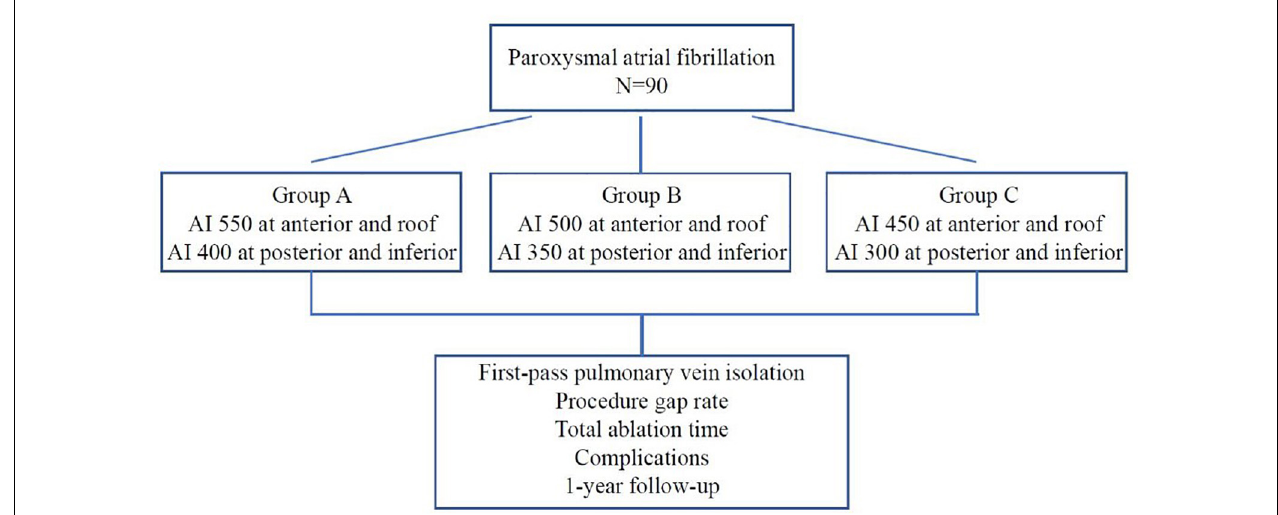
FIGURE 1 | The study flowchart.